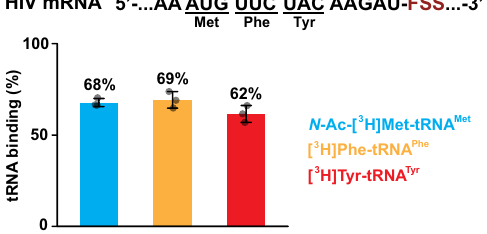
Fig. 4 Extension of the stem length eliminates the FSS-induced inhibition of tRNA binding. The ribosomes, which were programmed with HIV stem- extended FSS mRNA and contained P-site N -Ac-Met-tRNA Met , were incubated with EF-G GTP, EF-Tu GTP, Phe-tRNA Phe , and Tyr-tRNA Tyr for 5 min before loading ribosomes onto a nitrocellulose fi lter and washing away unbound aa-tRNA. The experiment was repeated three times with one of the three aminoacyl-tRNAs radio labeled, i.e. using N -Ac-[ 3 H]Met- tRNA Met (blue bar), [ 3 H]Phe-tRNA Phe (orange bar), or [ 3 H]Tyr-tRNA Tyr (red bar). Similar experiments were performed with ribosomes programmed with HIV Δ FSS mRNA. The binding of each radio-labeled tRNA to ribosomes programmed with the HIV stem-extended FSS mRNA is shown relative to that observed in ribosomes programmed with the HIV Δ FSS mRNA. Data are presented as mean values ± standard deviations of three independent measurements. Source data are provided as a Source Data fi